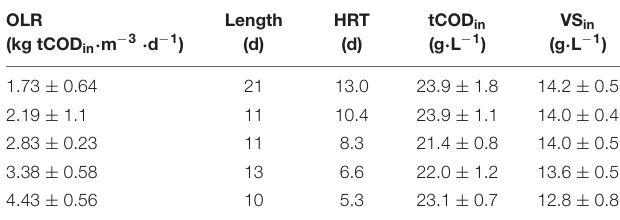
TABLE 2 | Operational conditions used in the CSTR